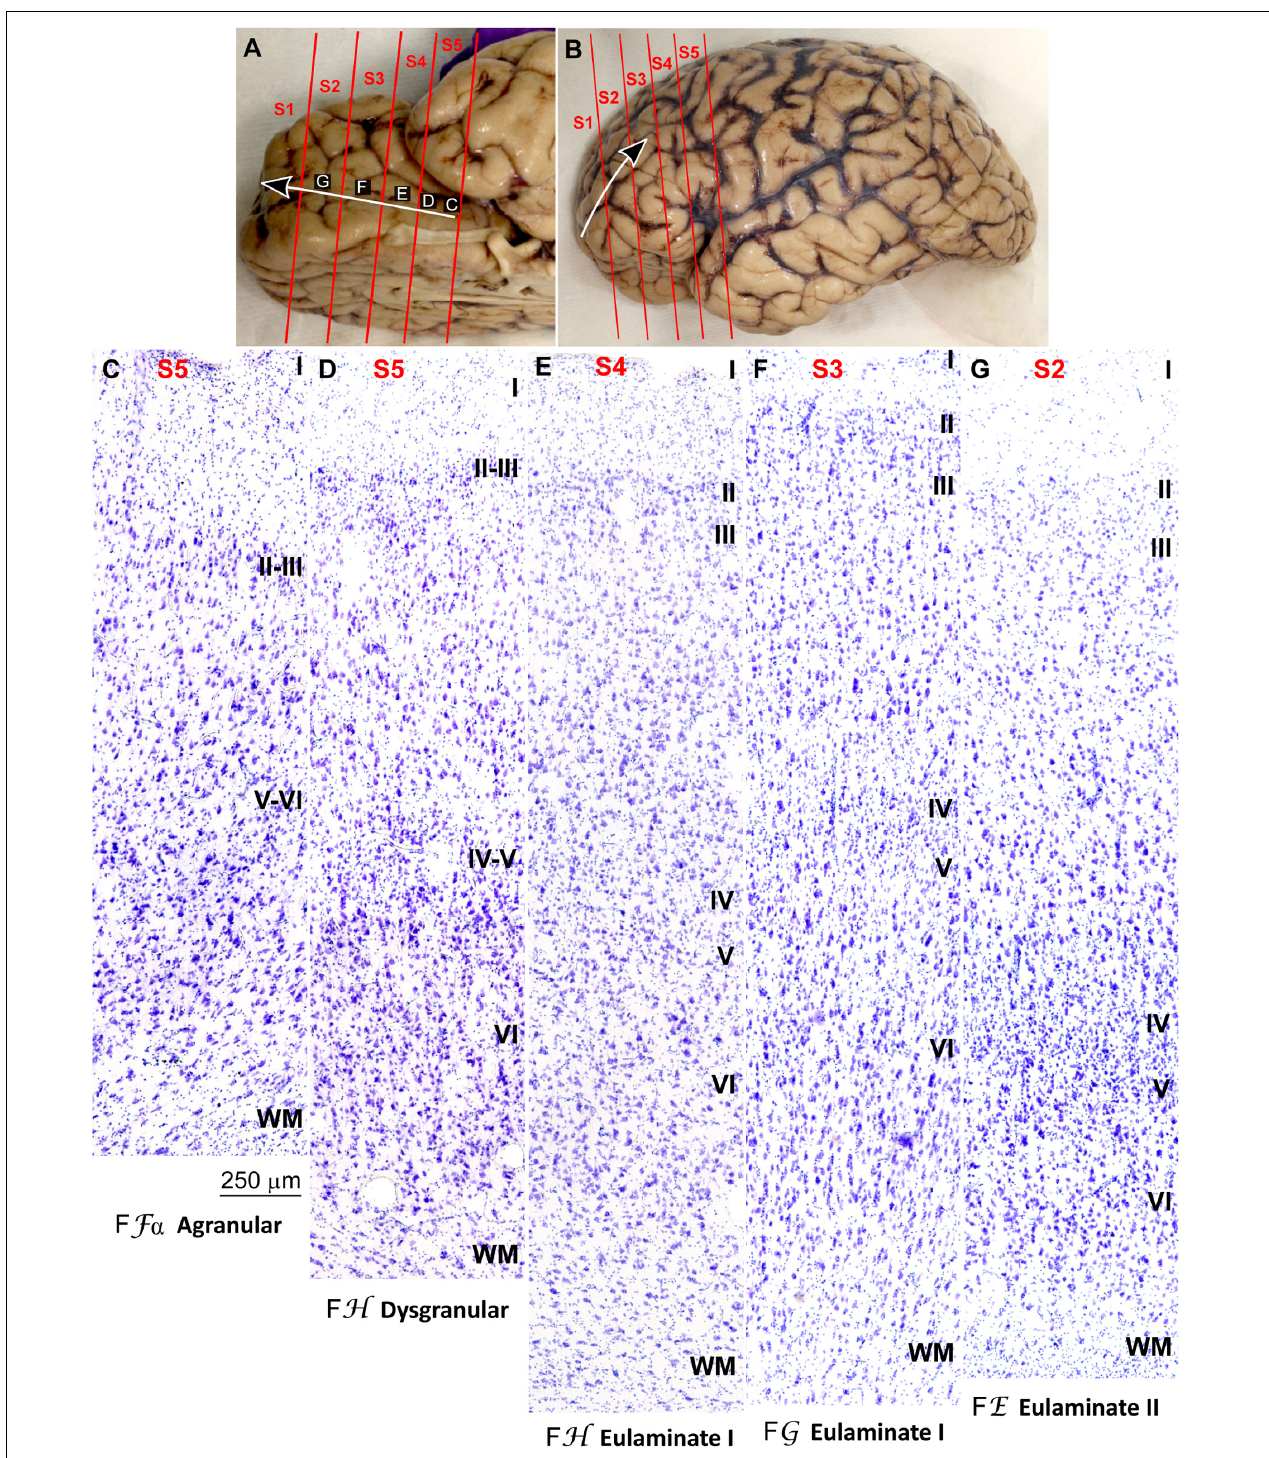
FIGURE 2 | Systematic and gradual variation of laminar structure across areas of the paraolfactory trend in the human prefrontal cortex: Orbitofrontal areas. (A,B) , Orbital (A) and lateral (B) views of the left hemisphere from the brain (case HCD): red lines show the planes of separation of coronal slabs; black and white arrows indicate laminar differentiation along the paraolfactory trend. (C–G) , Micrographs of the orbital cortex in Nissl stained sections at the levels indicated in (A) ; the areas according to the Atlas of von Economo and Koskinas (1925/2008) and the cortical type are indicated below each micrograph; see the text for description of laminar features. S1, S2, S3, S4, S5, indicate coronal slabs from anterior to posterior; WM, white matter. Roman numerals indicate cortical layers. Calibration bar in (C) applies to (C–G) .